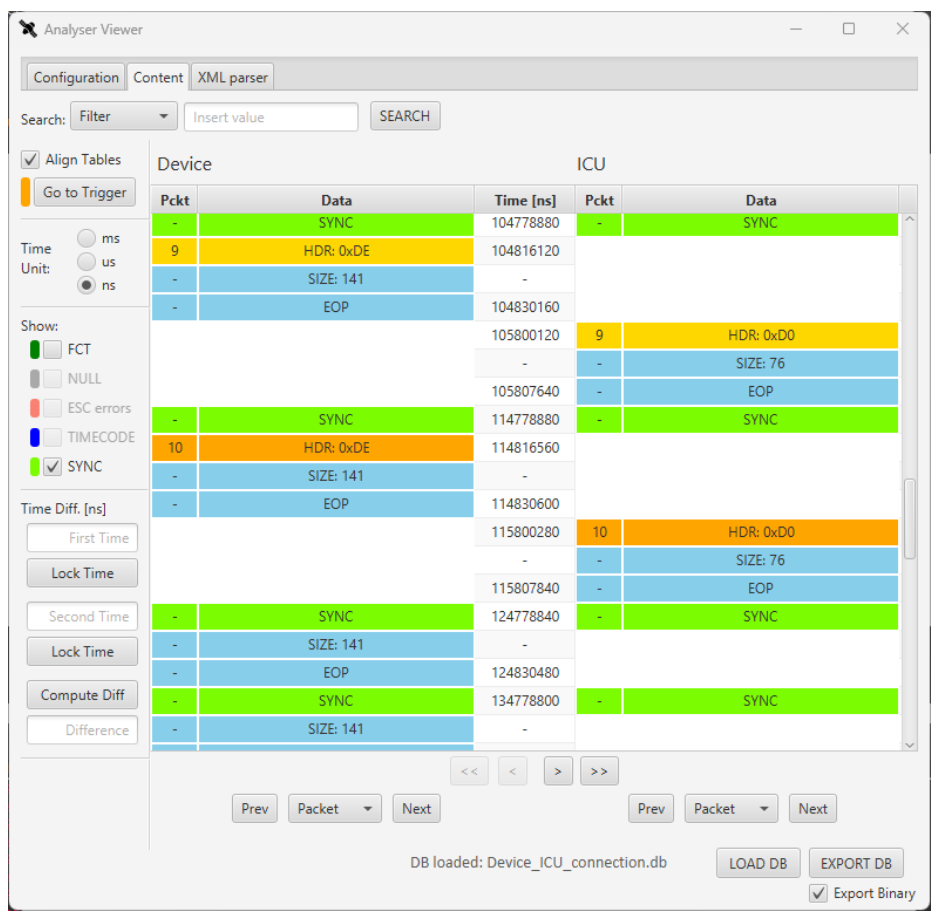
Figure 8. SpaceART Sniffer GUI visualization of packet exchanged in Test 1. The 10th packet on the left column (i.e., transmitted by the device) is highlighted with an orange header, indicating that the SpaceART Sniffer trigger was raised for this packet, as expected. In the visualization, the SYNC signals are also shown with green lines, as a signal transmitted on both channels. By evaluating the time between two consecutive SYNC signals we can notice that they are transmitted with a period of 10